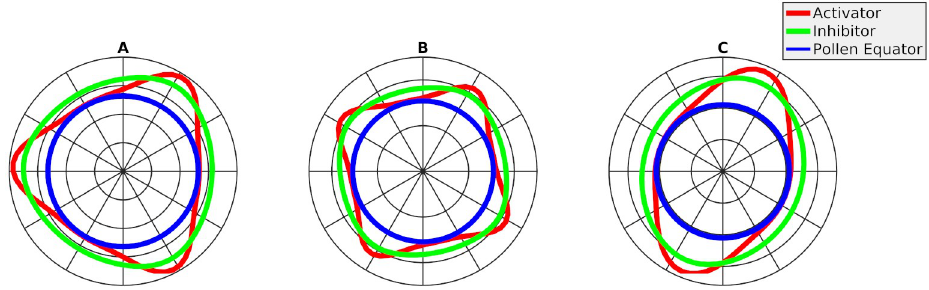
Fig 3. Examples of patterns observed on the 1D domain. The 1D domain representing the pollen equator is shown in blue, the concentration of the activator is in red, and the concentration of the inhibitor is in green. We could commonly observe a three-spike pattern (A), a four-spike pattern (B), and a two-spike pattern (C). The concentration of the activator fluctuates between zero and its maximum, while the concentration of the inhibitor never gets reduced to zero, even between the spikes. The results were obtained running Eqs 1 and 2 with parameter values given in Table 1.